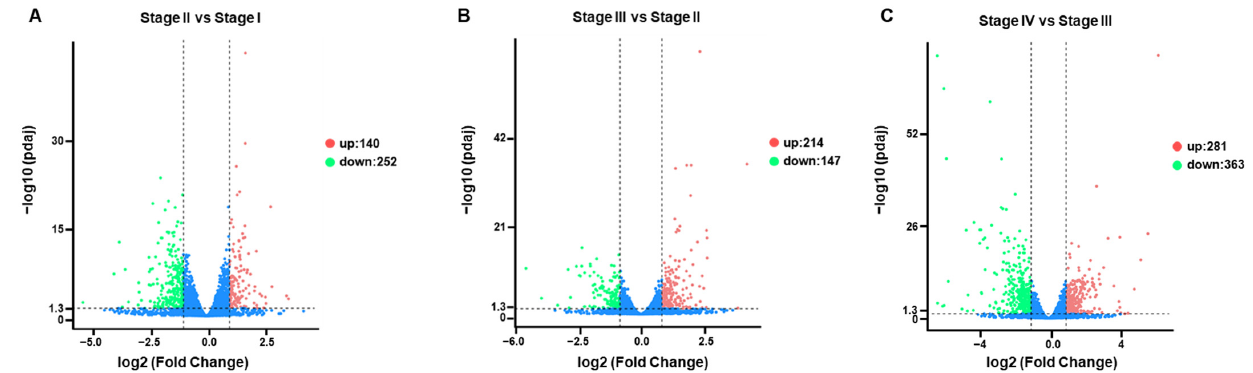
Figure 6. Volcano plots showing the expression level of each unigene. Limits defined by p -value ≤ 0.05 and |log 2 ratio| ≥ 1. Red points represent upregulated genes; blue points represent downregulated genes. ( A ) Volcano plots showing the expression level of each unigene of Stage II compared to Stage I. ( B ) Volcano plots showing the expression level of each unigene of Stage III compared to Stage II. ( C ) Volcano plots showing the expression level of each unigene of Stage IV compared to Stage III.